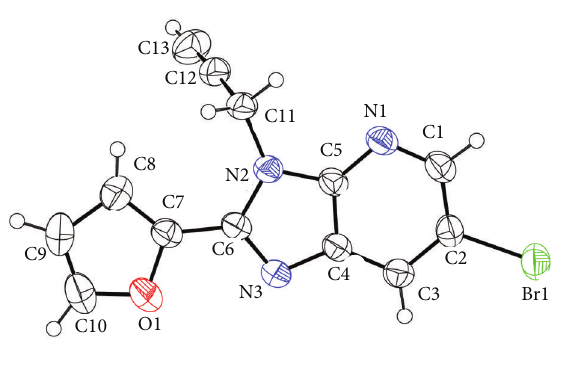
Figure 1: Projection view of 1